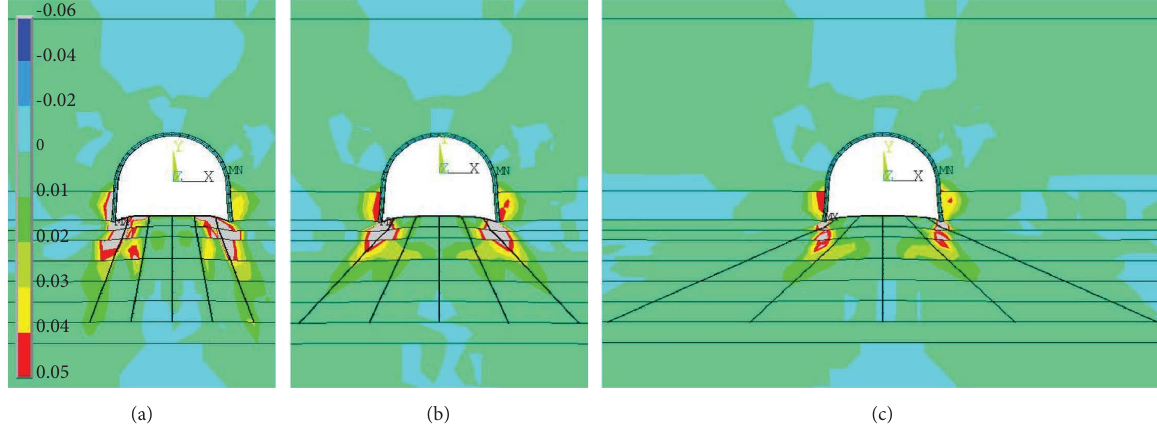
Figure 19: Total maximum principle strain distribution around the roadway after reinforcement: (a) foor support scheme I; (b) foor support scheme II; (c) foor support scheme III.